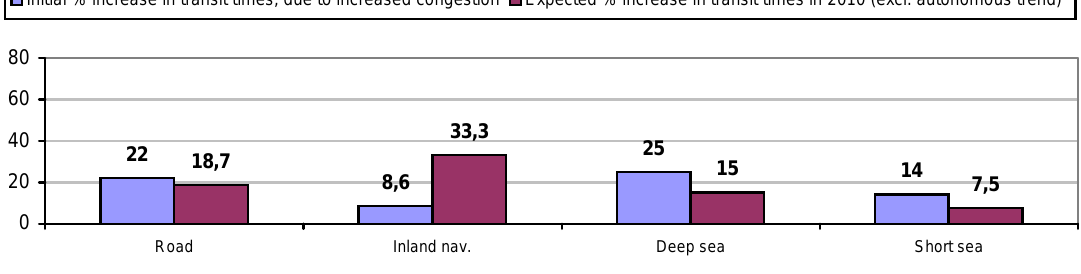
Figure 5. Comparison of assumed delay due to the congestion scenario and expected delay in transit times in